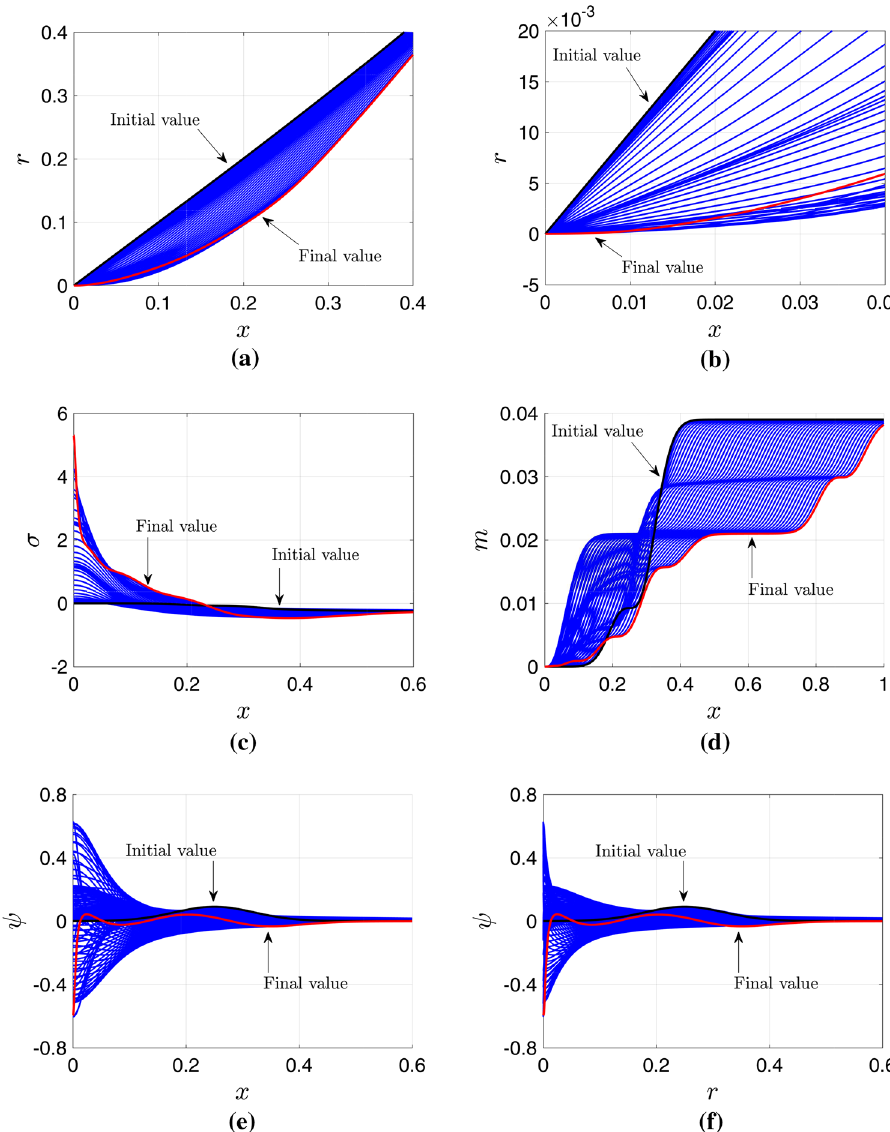
Fig. 1 Evolution of the metric components and scalar field on consecutive time slices. The time interval between two consecutive time slices in a – d is 400 (cid:2) t = 0 . 01, and in e , f is 200 (cid:2) t = 0 . 005. The total time in the simulations is 24360 (cid:2) t = 0 . 609. b Near the center, r ( t , x ) ≈ D ( t ) x . So for fixed t , r is a linear function of